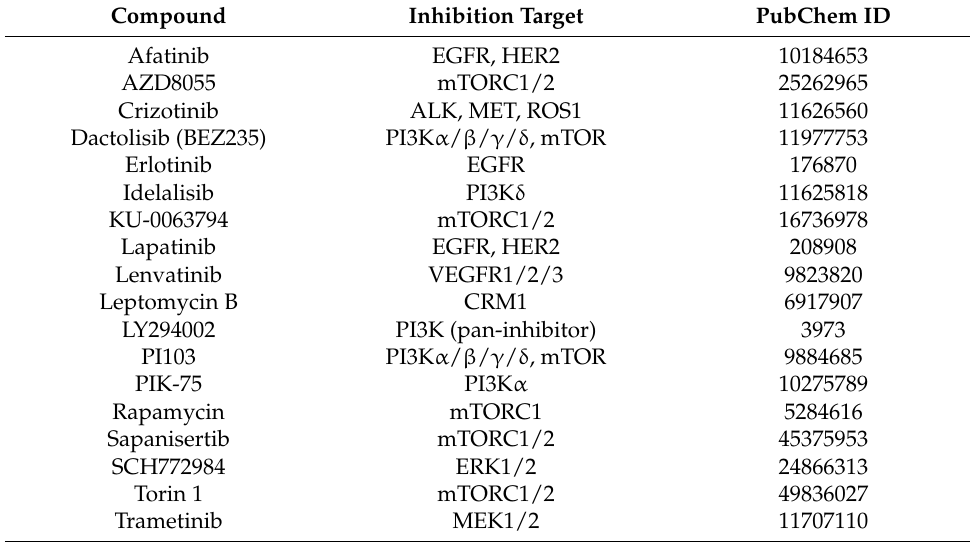
Table 1. Chemical compounds used to treat reporter